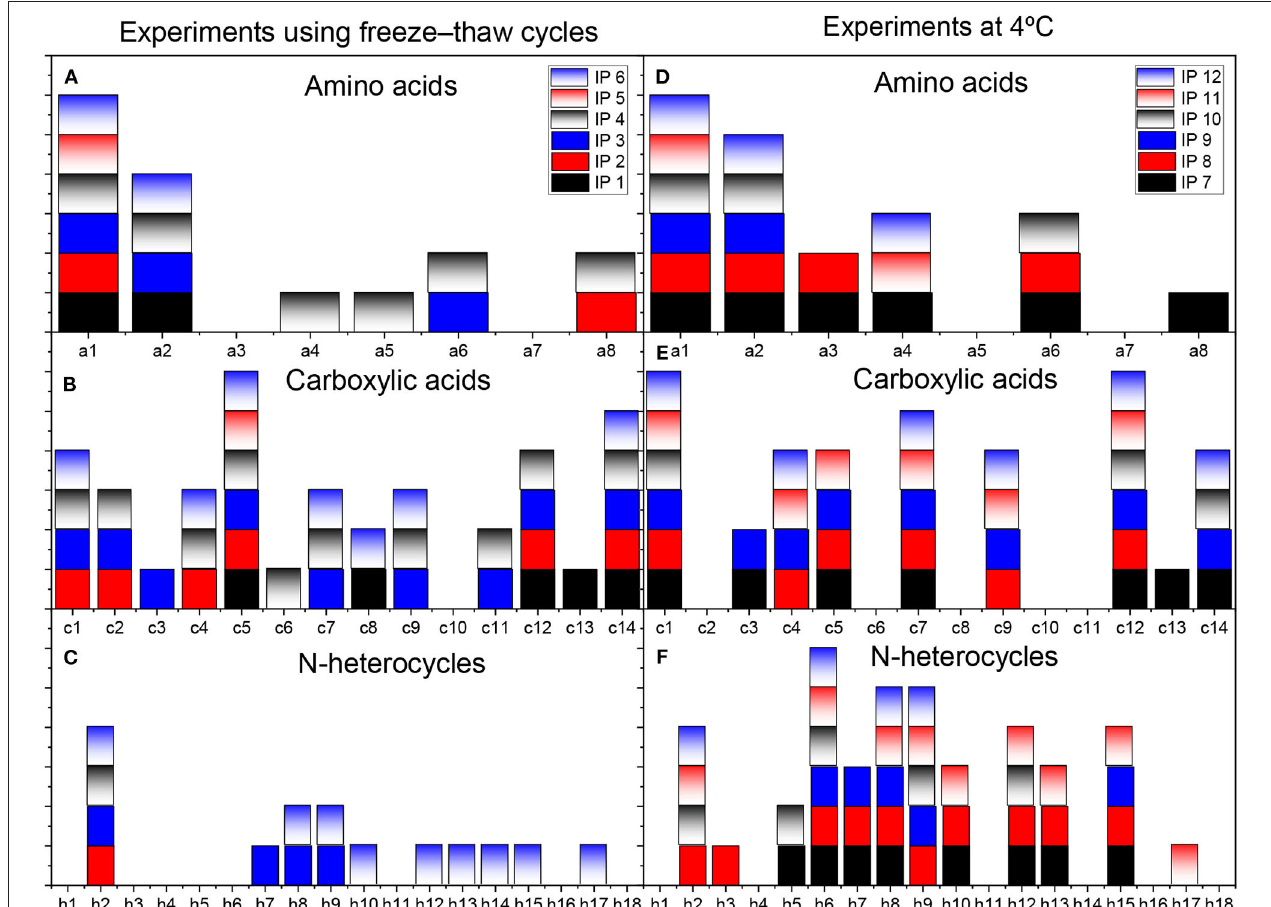
FIGURE 2 | Organic polar compounds identified as their TMS-derivatives by GC-MS in acid-hydrolyzed insoluble NH 4 CN polymers synthesized under the conditions indicated in Table 1 . (A–C) Correspond to the amino acids, carboxylic acids, and N-heterocycles, respectively, found in insoluble NH 4 CN polymers synthesized in the presence of freeze-thaw cycles; (D–F) correspond to amino acids, carboxylic acids, and N-heterocycles, respectively, found in insoluble NH 4 CN polymers synthetized at 4 ◦ C. The numbers on the abscissa correspond to the enumeration of analytes shown in Figure 1 . The colored bars indicate the presence of a concrete analyte in the corresponding